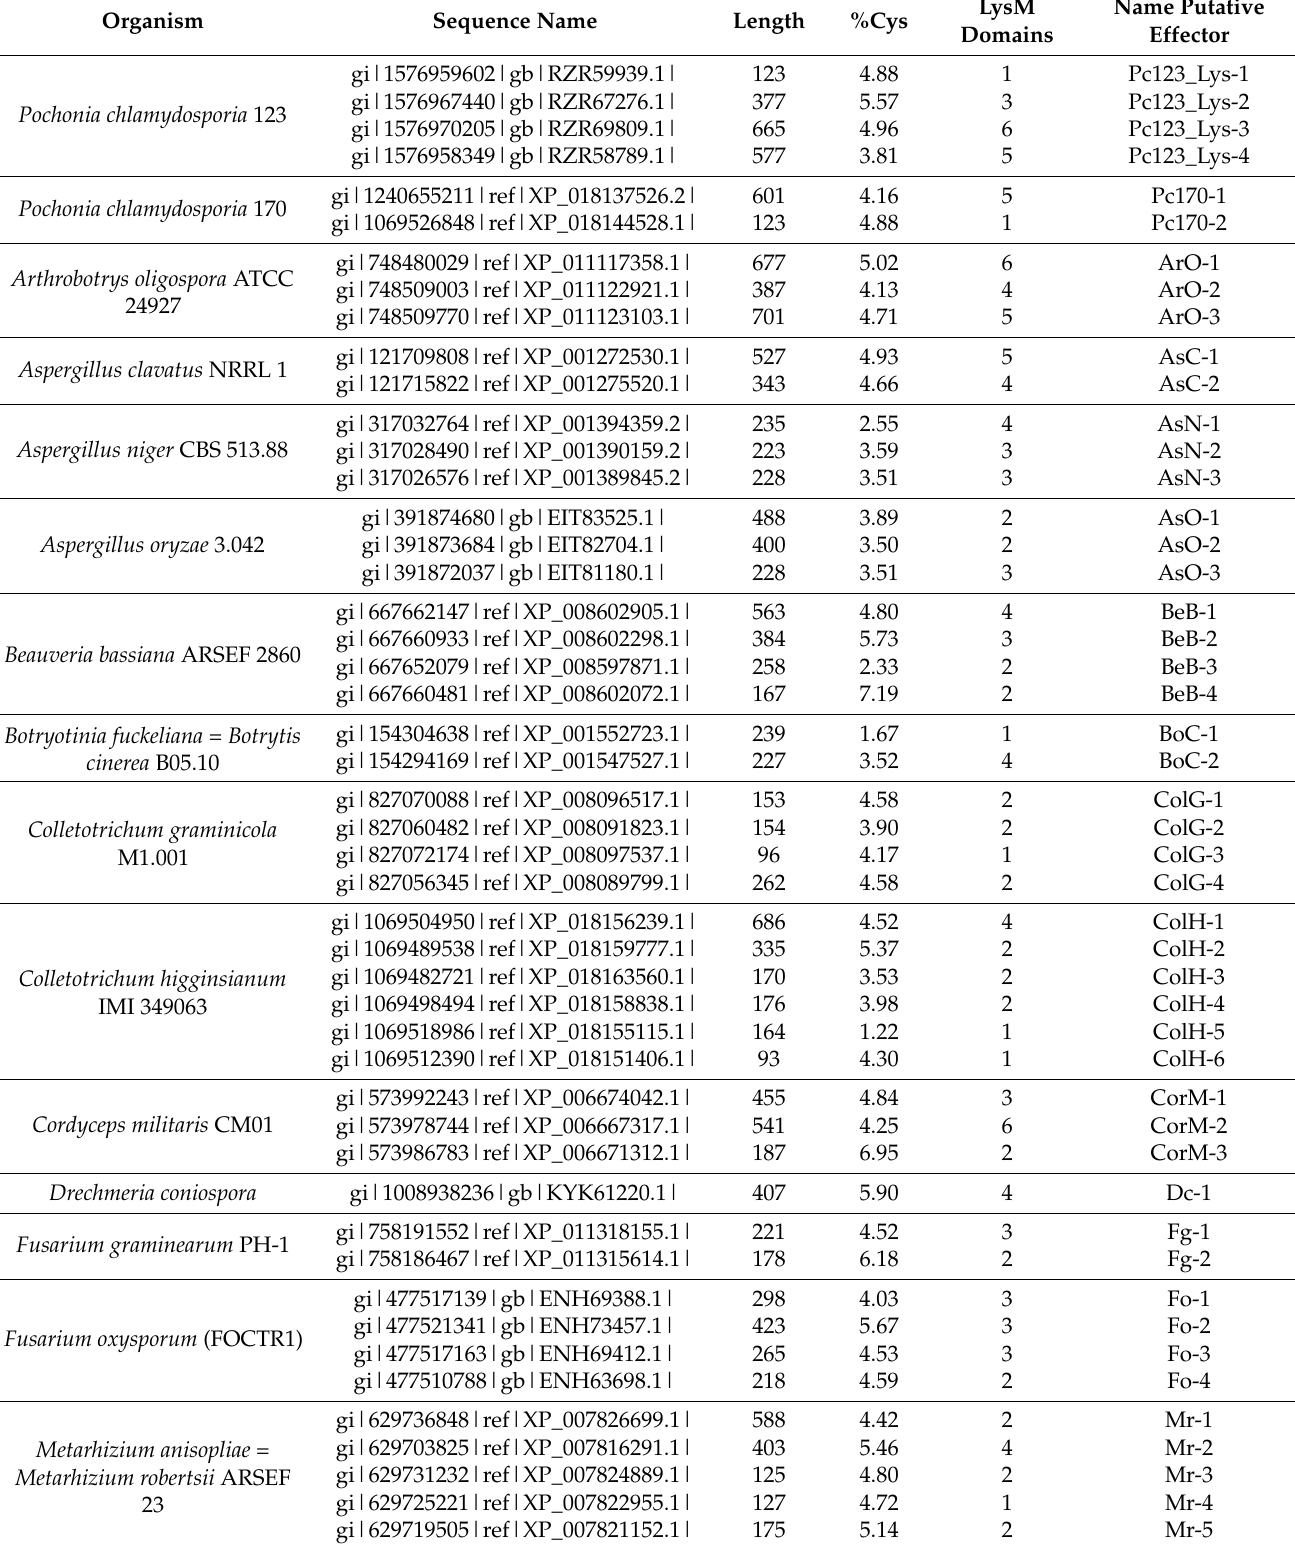
Table 1. Consensus table of 27 organisms containing putative LysM effectors in their proteome. NCBI Reference Sequence, length, percentage of cysteines (% Cys), number of LysM domains (predicted with HMMERscan) and the sequence name to refer to each effector are